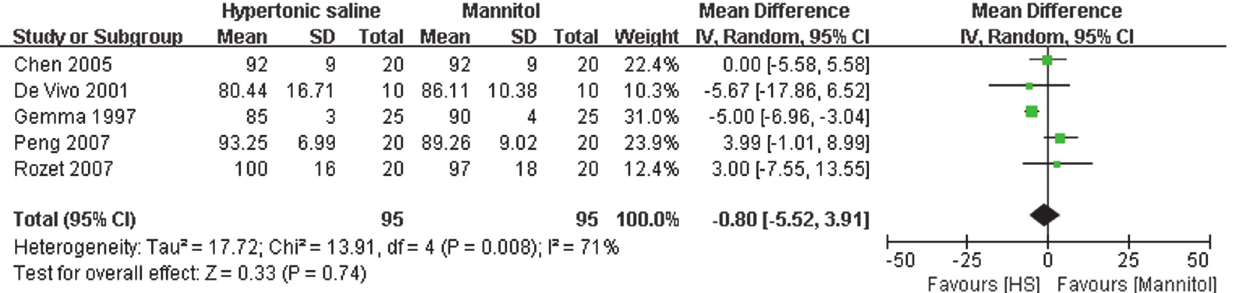
PLOS ONE | DOI:10.1371/journal.pone.0117314 January 30,